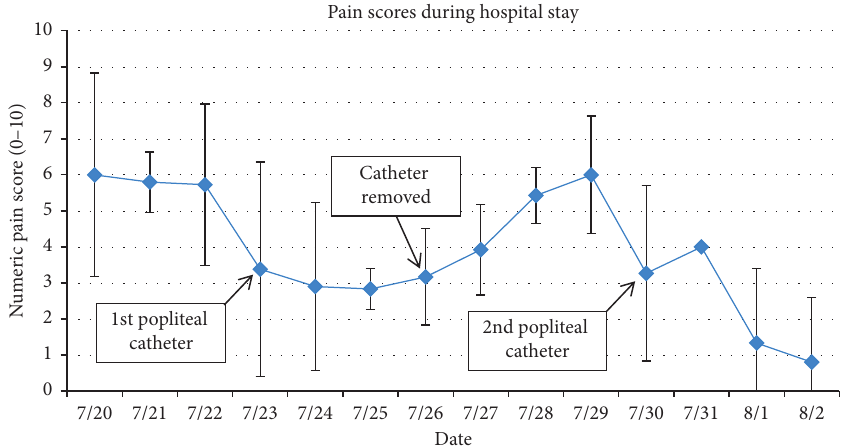
Figure 1: Pain scores during hospital stay. The line graph displays mean numeric pain scale scores for each hospital day, ranging from 0 (no pain) to 10 (worst possible pain). Standard deviation bars are displayed for each